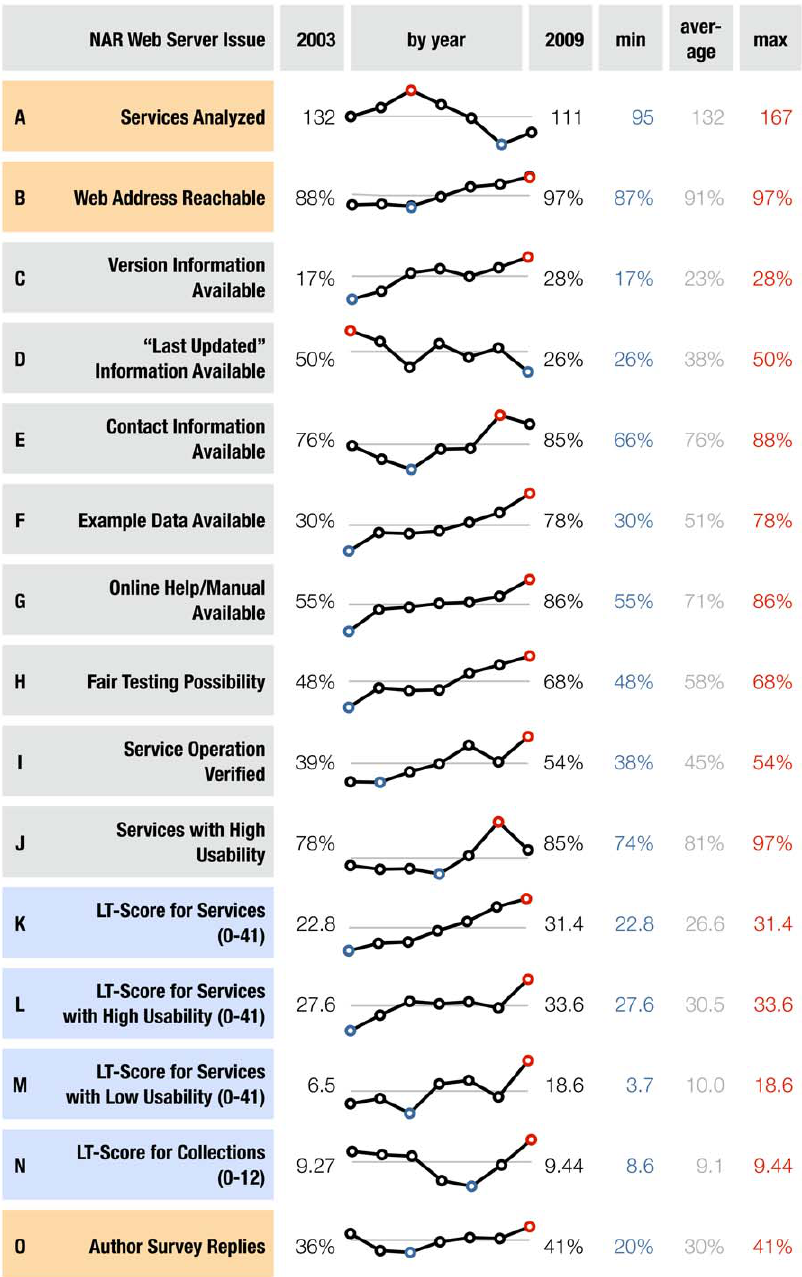
Figure 1. Charts for many criteria used to evaluate the services, by year of publication. This figure shows numerical values and sparklines [27] for the criteria of every year the NAR Web Server Issue was published, listing explicitly the values for 2003, 2009, the minimum value of these years in blue (labeled min), the arithmetic mean in gray (labeled mean) as a straight line, and the maximum number in red (labeled max). (A) Services analyzed lists the absolute number of services we extracted from that issue of NAR. Some publications describe a whole collection of services, which were not evaluated individually, but rather by criteria apt for collections, and appear as a single service in the graph. (B) Web address reachable is a relative number of URLs that did not return an error message when accessed in a browser (as described in [3]), but may contain services that are not operational while still displaying their regular Web page. (C)–(G) We tried to locate version information , ‘‘last updated’’ information , contact information , example data , and online help/manual , on the service’s Web page to the best of our abilities. As the requirements for submissions to NAR Web Server Issues tightened, we see an increase in these numbers, except for the version information, which becomes pertinent as the Web service ages. (H) For services to give us a fair testing possibility , we required either easily obtainable example data or standard file types such as FASTA, PDB, GFF, etc.(cf. Methods). (I)–(J) The percentage reported in service operation verified is taken from the total number of services in that issue. We assigned usability scores from zero to three, services with high usability score either two or three. A high score is assigned to services with clearly arranged user interface widgets, the presence of default values and easily accessible help and usage information. It is low for services with strong restrictions on input data and crowded, unclear user interfaces without documentation. (K) The LT-Score is calculated for every service, on a range from zero to 41, and zero to twelve for every collection of services (see Methods). (L)–(M) As the LT-Score for services with high usability and low usability show, services with user interfaces that are well-arranged also have an above average LT-Score, and services with unclear interfaces score significantly lower. (N) The